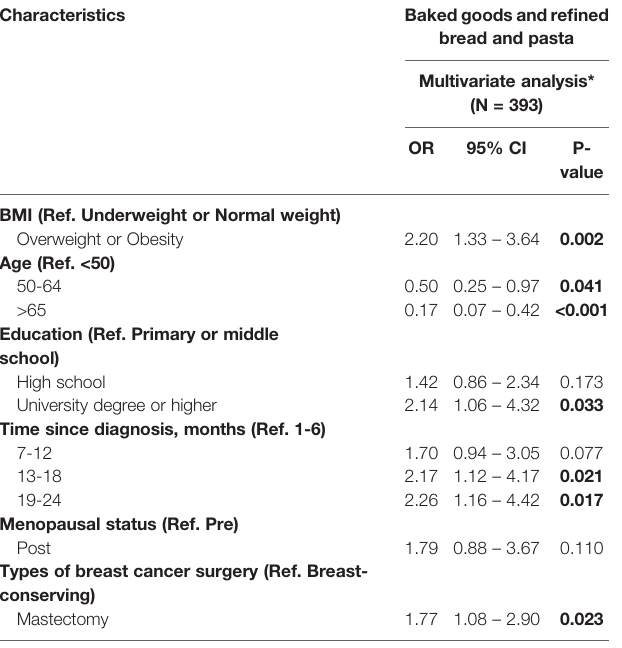
TABLE 3 | Factors associated with changes in baked goods, re fi ned bread and pasta consumption. Characteristics